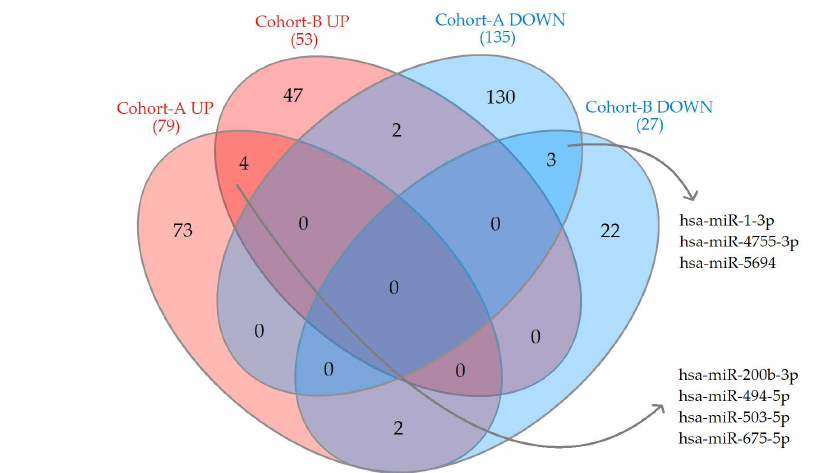
Figure 2. Venn diagram of upregulated and downregulated miRNAs in both